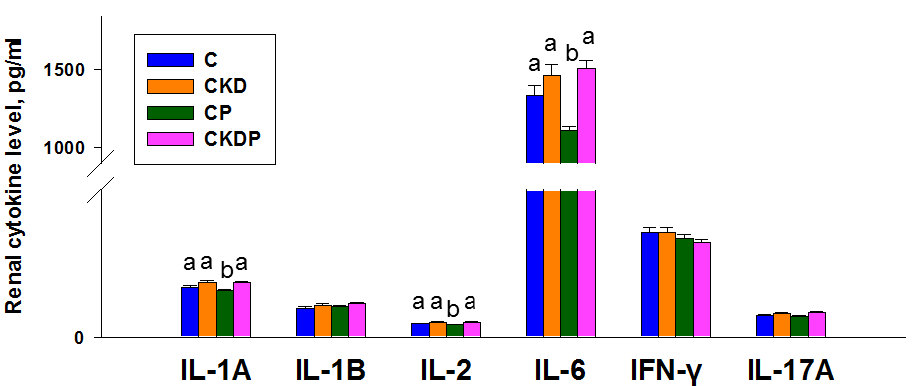
Figure 4. Effect of maternal CKD and propionate (P) supplementation on renal cytokine levels in offspring at 12 weeks of age. The letters a and b above the bars show significant differences between groups ( p < 0.05, one-way ANOVA); N = 7–8/group. C = control; CKD = adenine-treated rats; CP = control rats received propionate; CKDP = adenine-treated rats received propionate.